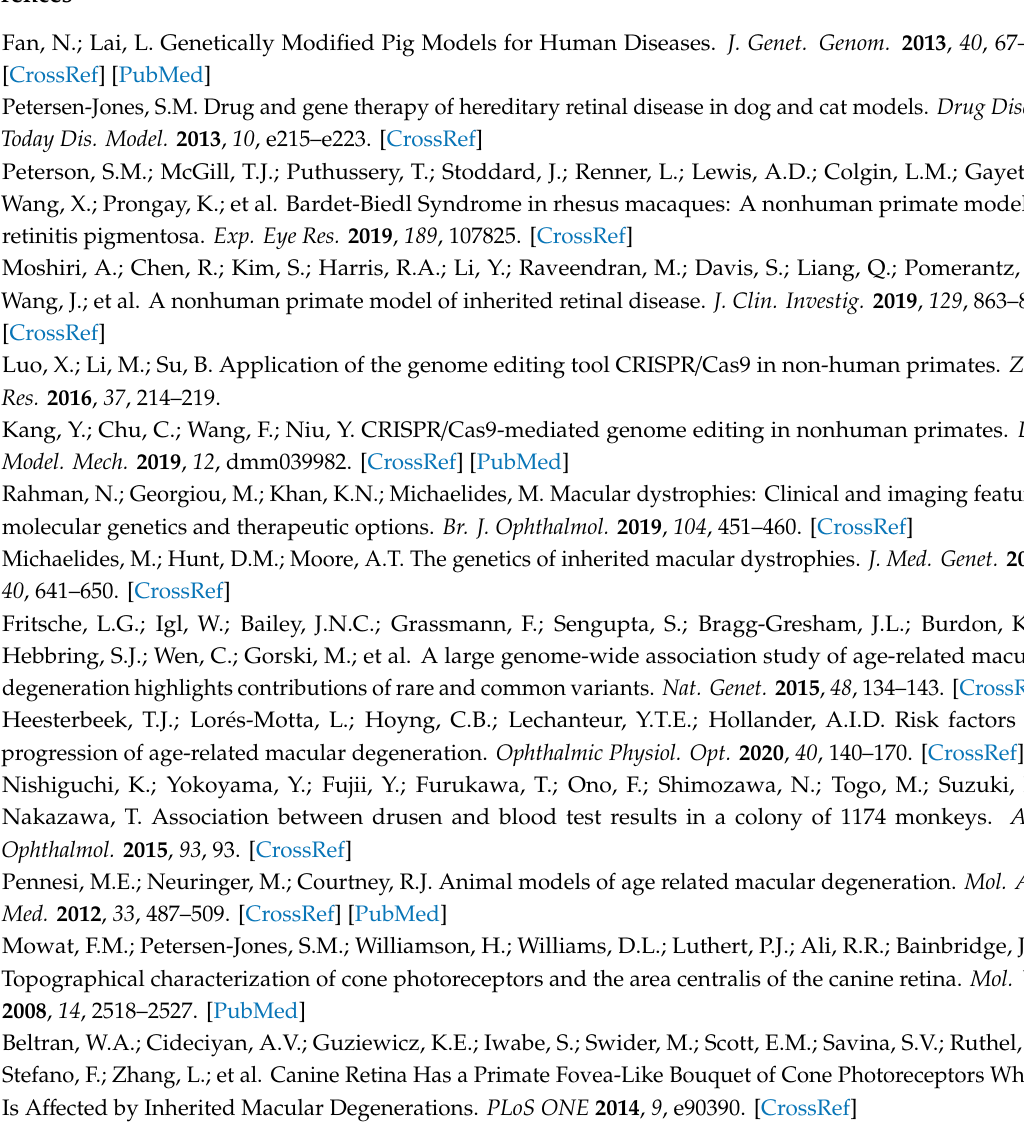
Table S1: List of mutations in large animal models of inherited retinal disease and